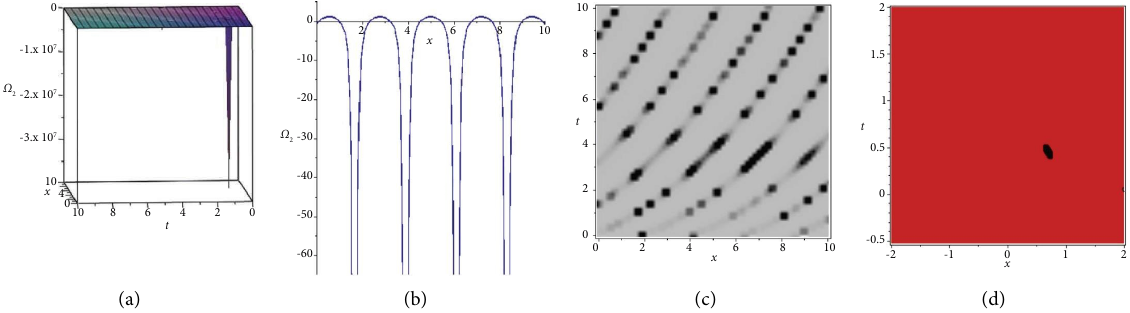
Figure 1: Te graphics of ϕ plot (d) Contour plot.